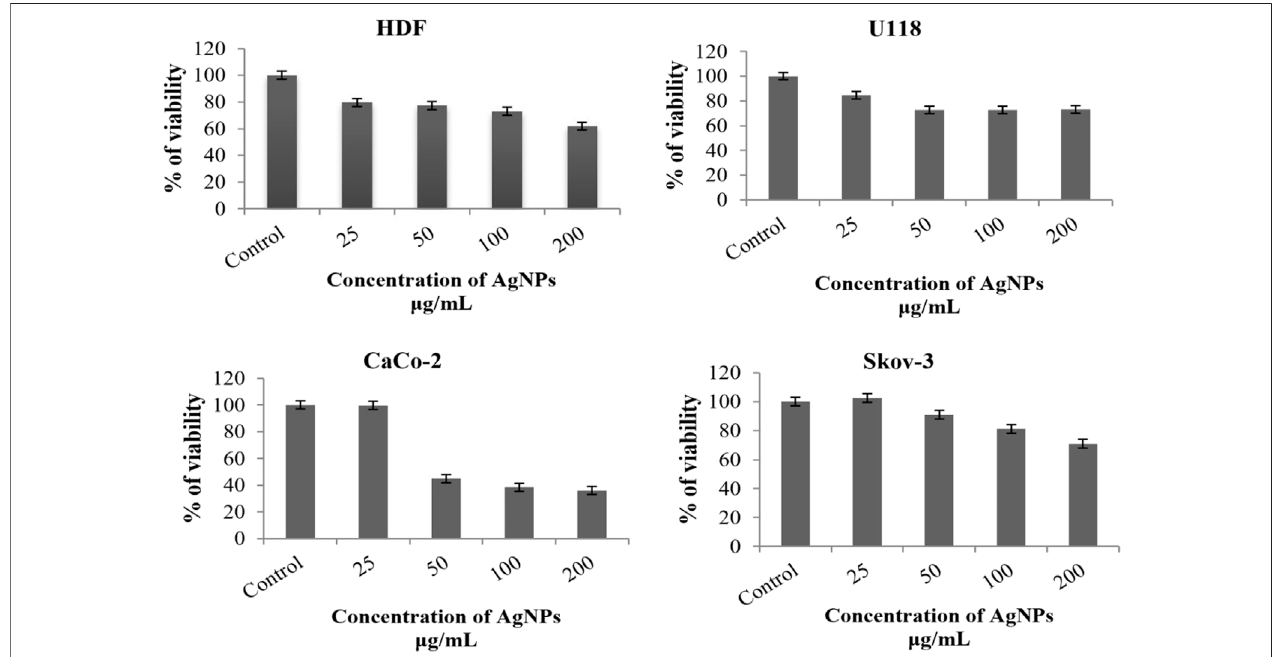
FIGURE 9 | Evaluation of the percentage viability rates as a result of the cytotoxic effect of AgNPs 2 days after combining them with CaCo-2, U118, HDF, and Sk- ov-3 cell lines.